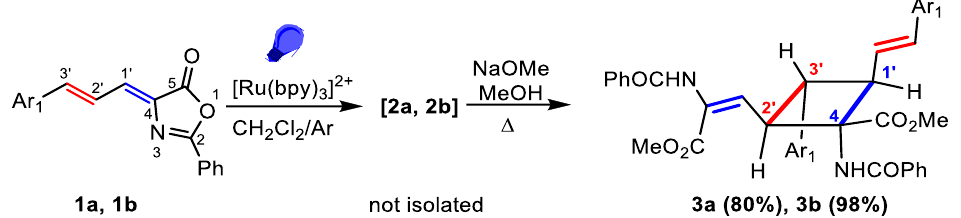
Figure 6. Selective formation of bis-amino acids 3 from allylidene-5(4 H )-oxazolones 1 in a one-pot, two-steps synthesis .